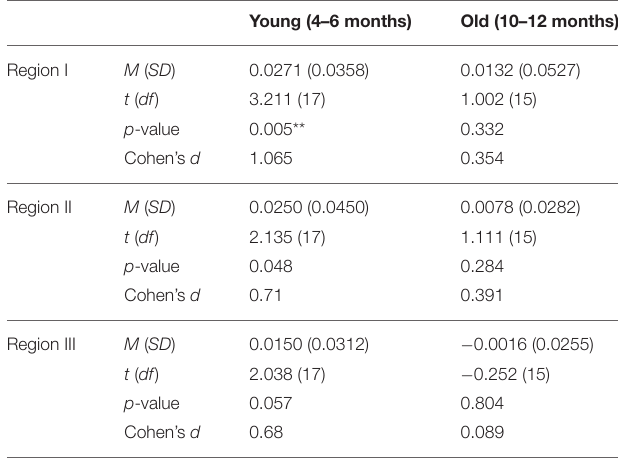
TABLE 3 | Mean (SD) HbO responses for the young and old age groups of Experiment